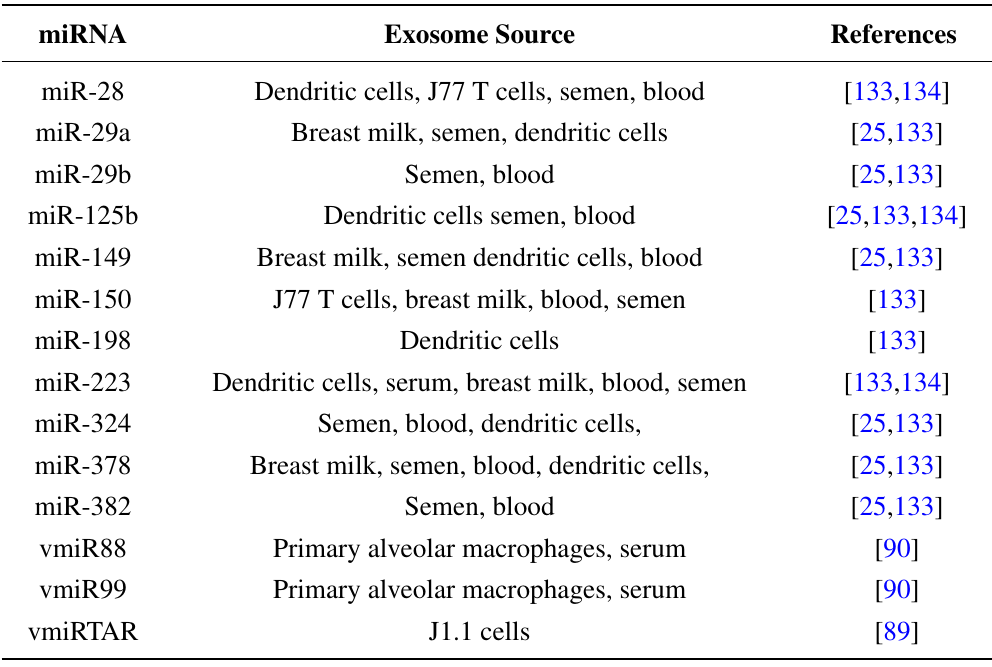
Table 1. HIV-1-relevant miRNA found in